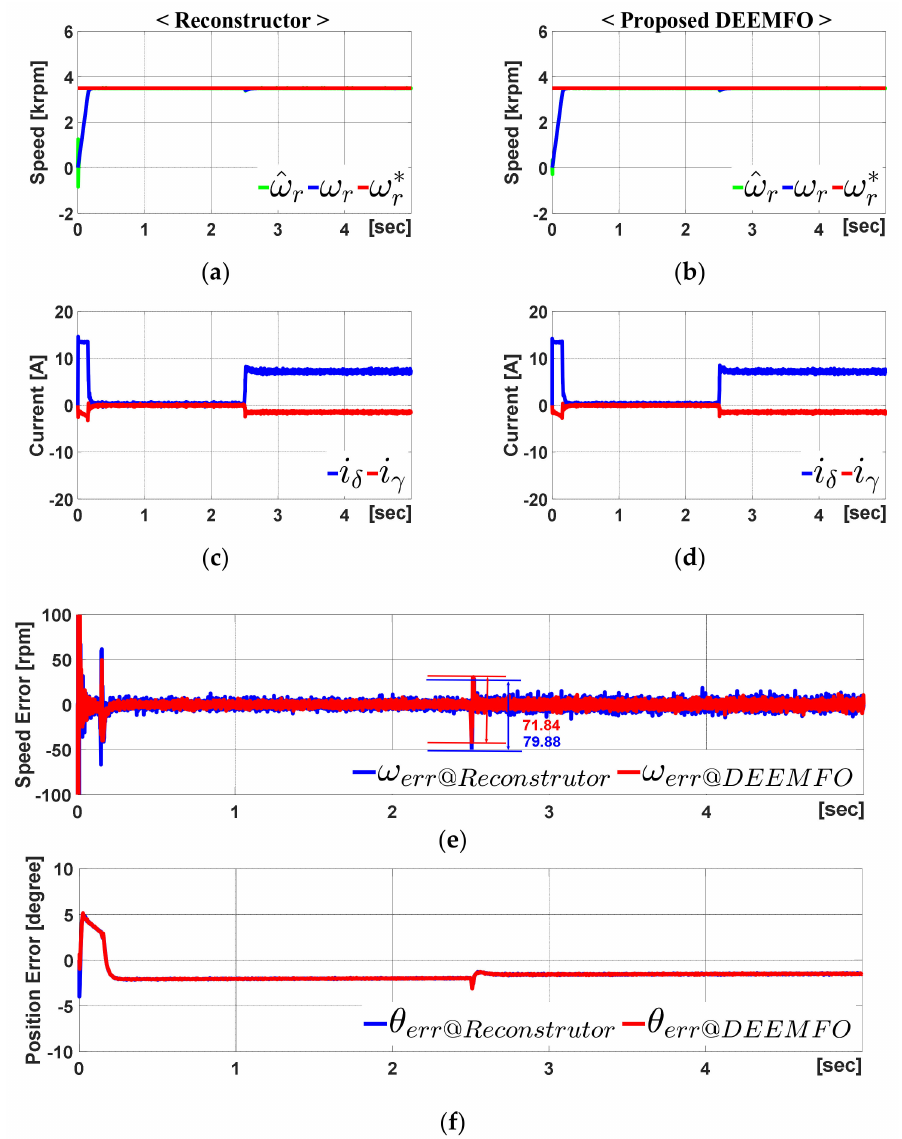
Figure 9. Simulation results under the condition of increasing the load torque from 0 Nm to 6